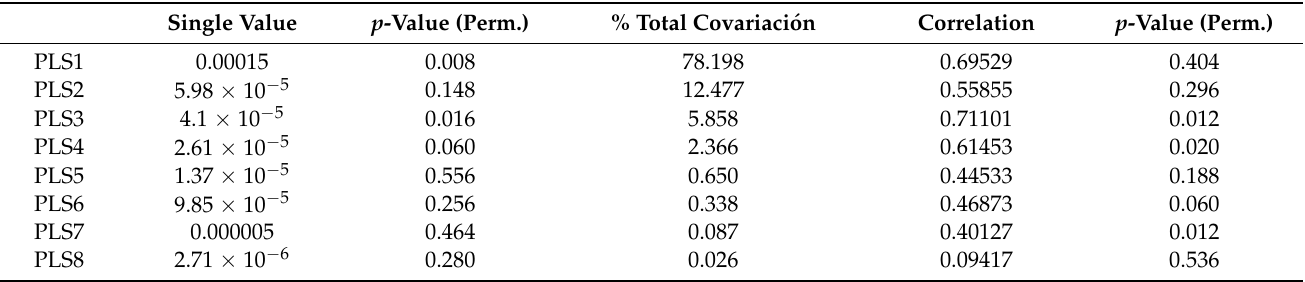
Table 2. Single values and paired correlations for the PLS scores between splanchnocranium and neurocranium.